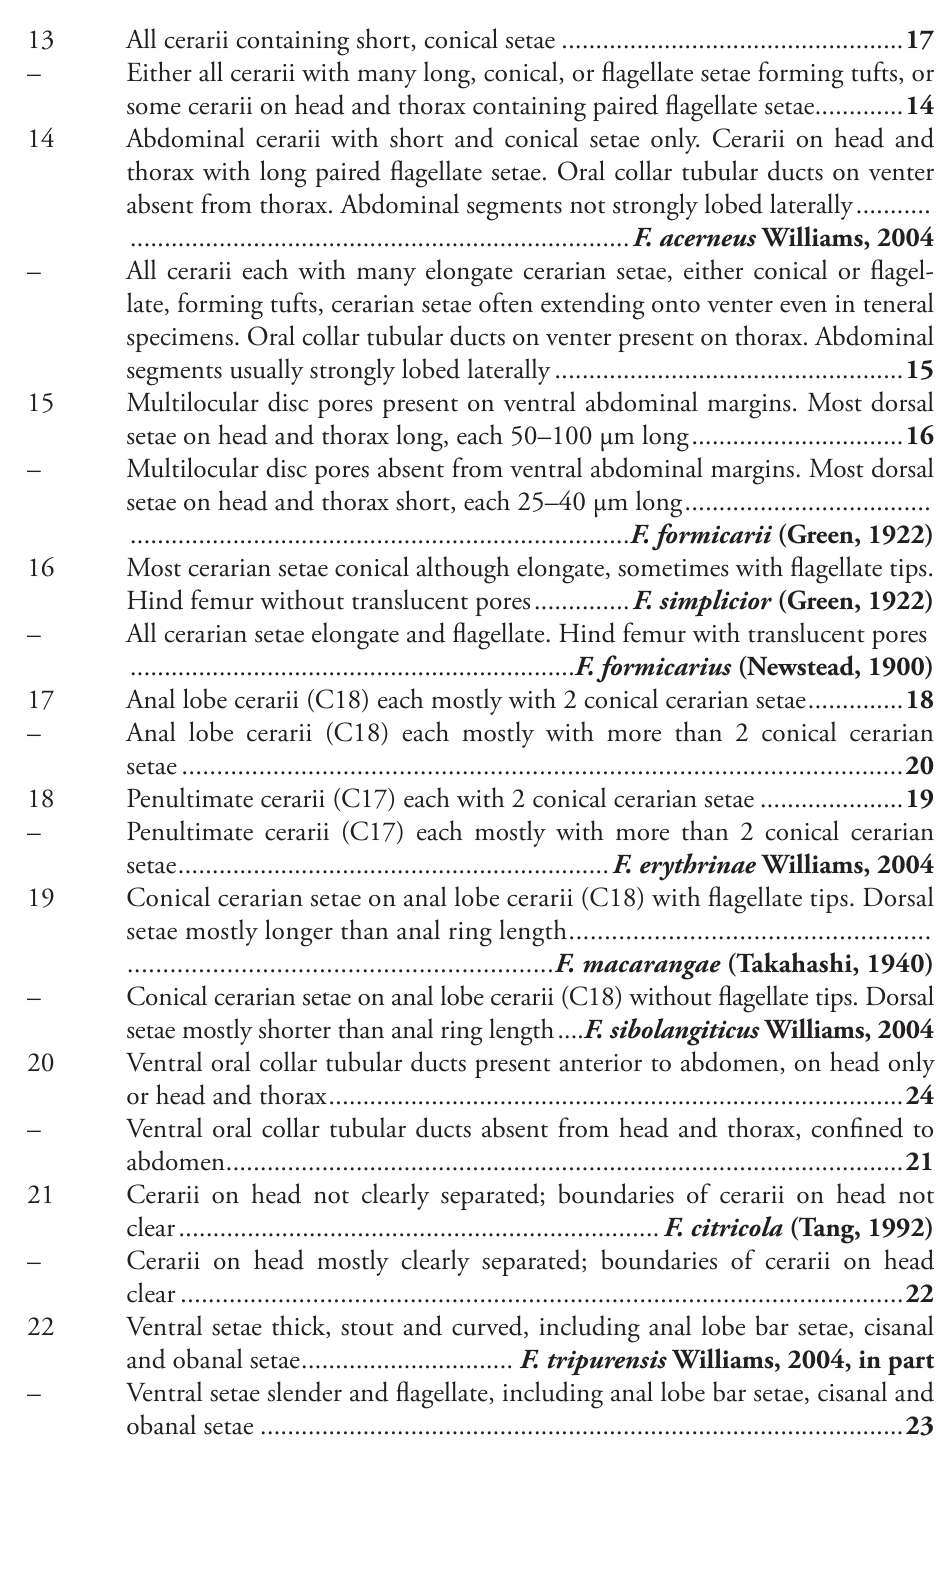
– Conical cerarian setae on anal lobe cerarii (C18) without flagellate tips. Dorsal setae mostly shorter than anal ring length .... F. sibolangiticus Williams, 2004 20 Ventral oral collar tubular ducts present anterior to abdomen, on head only – Ventral oral collar tubular ducts absent from head and thorax, confined to 21 Cerarii on head not clearly separated; boundaries of cerarii on head not – Cerarii on head mostly clearly separated; boundaries of cerarii on head 22 Ventral setae thick, stout and curved, including anal lobe bar setae, cisanal – Ventral setae slender and flagellate, including anal lobe bar setae, cisanal